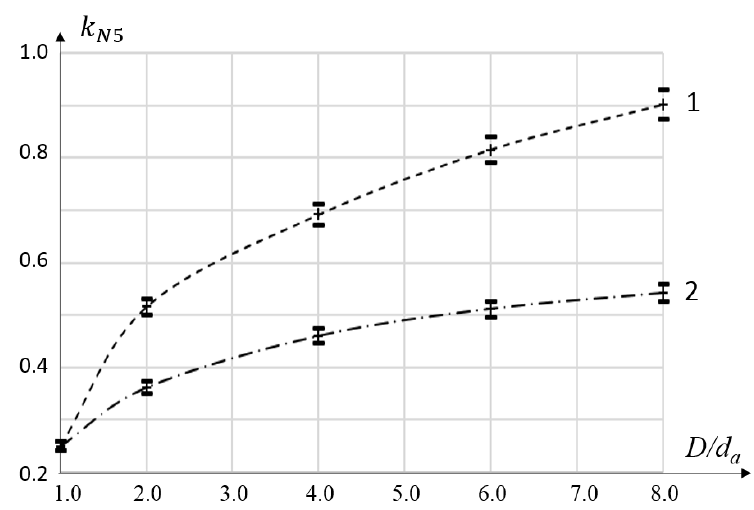
Figure 12. Influence of the ratio D / d a on the power factor k N 5 : 1—mixer design without partition plates; 2—mixer design with reflective partitions ( J = 4) (experimental data).